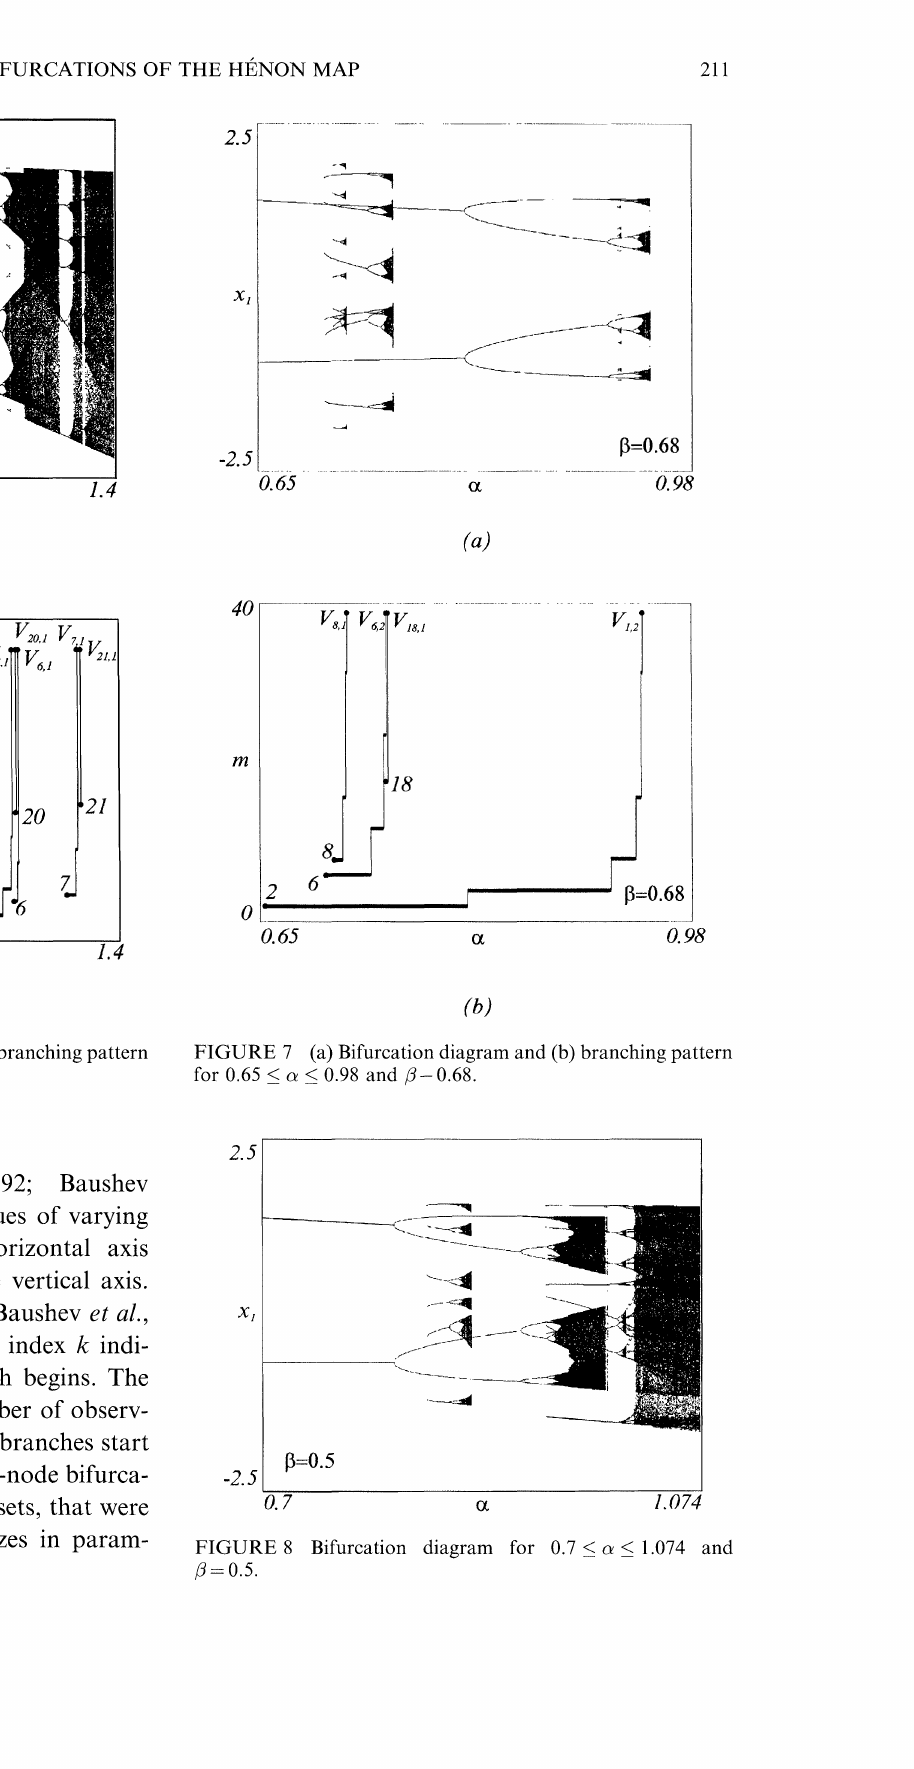
FIGURE 8 Bifurcation diagram for 0.7 < c _< 1.074 and